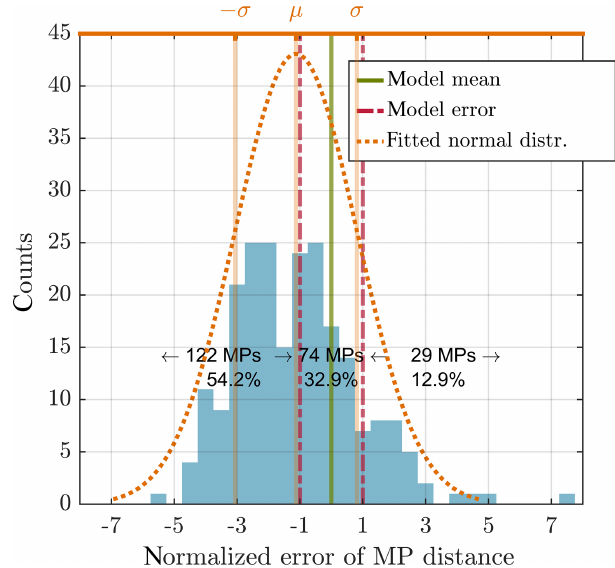
Figure 4. Normalized error of MP distance for innermost crossings. The error range is indicated by the vertical dashed dotted red line. 32 . 9% of MP transitions lay within the model error. The mean is at − 1 . 12, the standard deviation is 1 . 94 and the skewness is 0 .